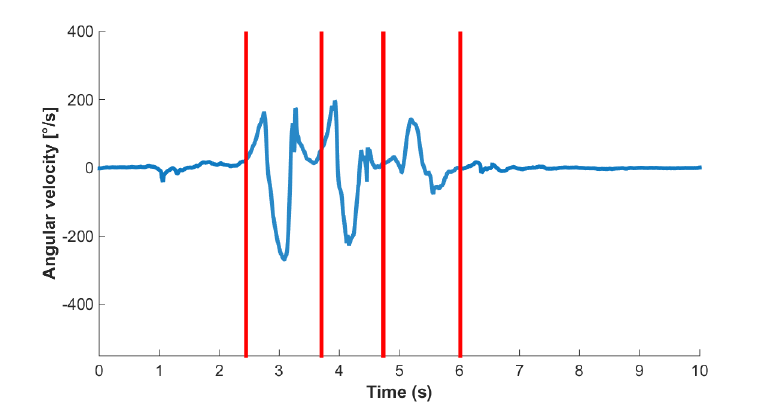
Figure 5. Sample gyroscope signal (blue line) consisting of three strides bounded by rest. Segment boundaries (SB) are shown as vertical